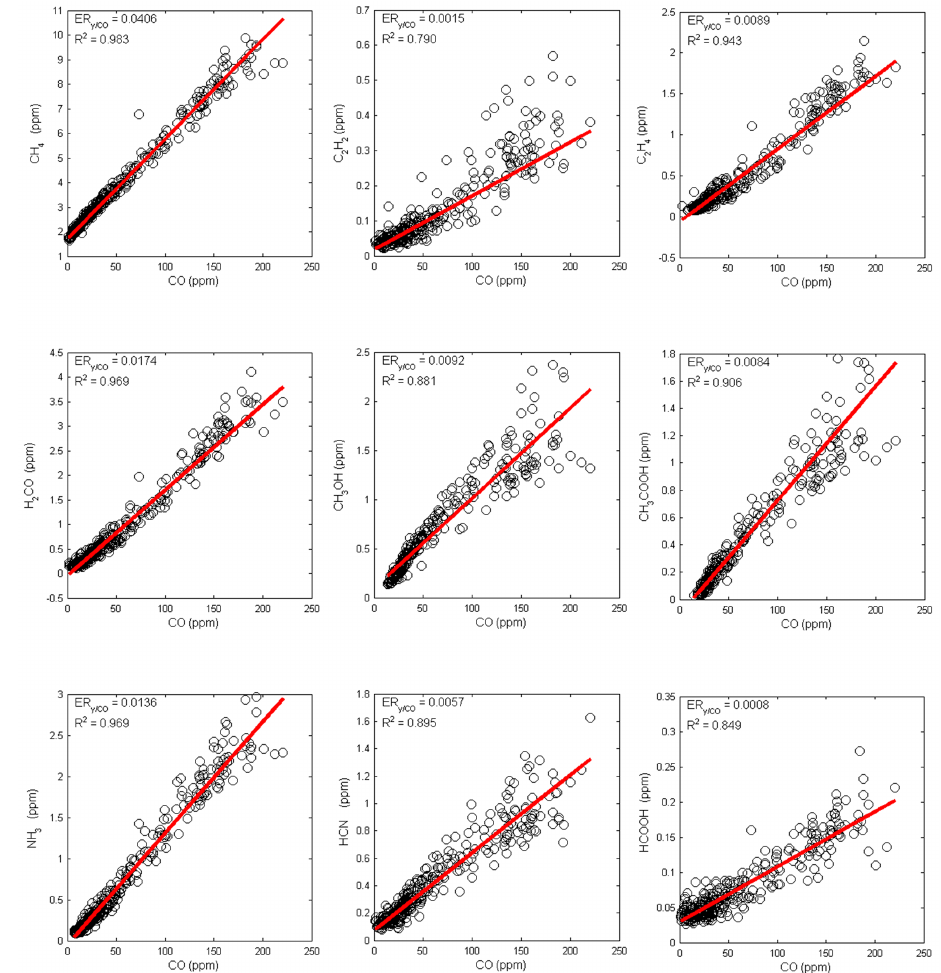
Figure 9. Same as Fig. 8, but with relation to